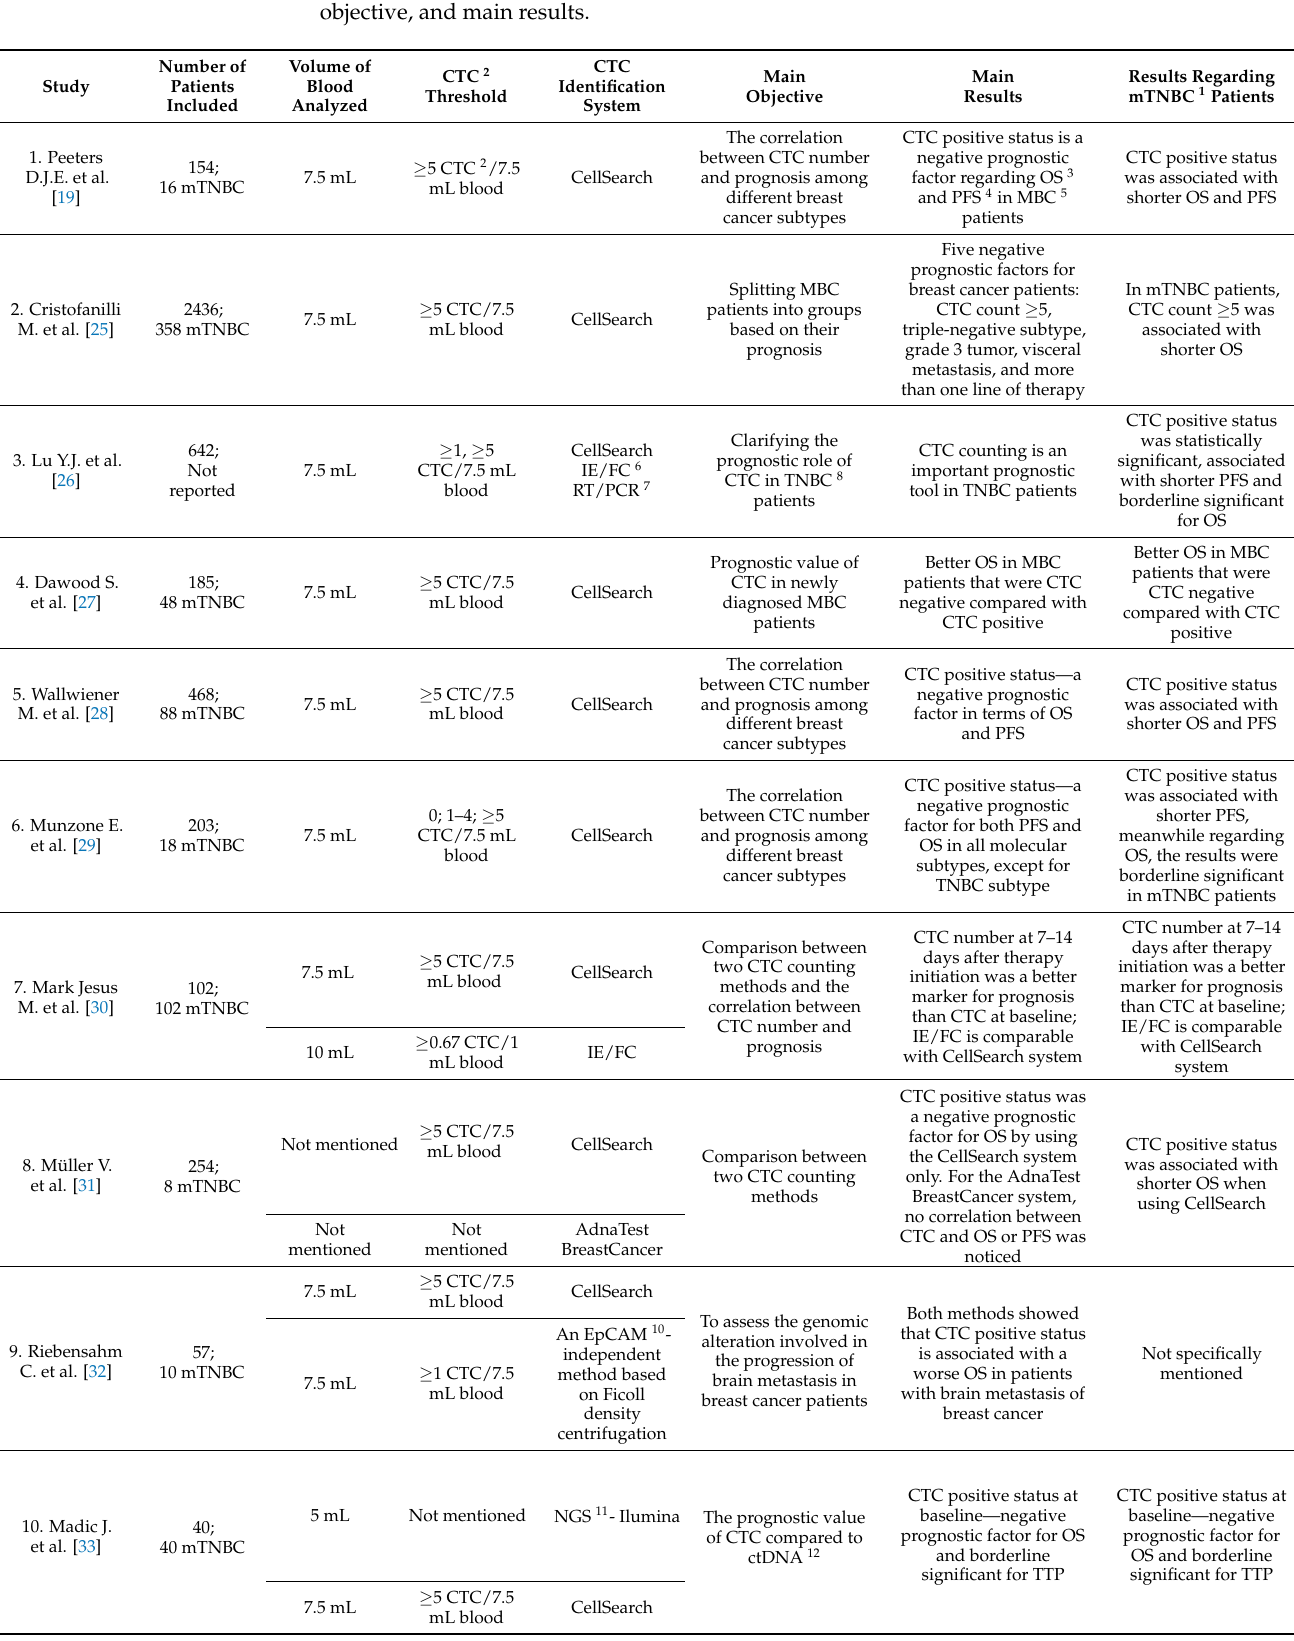
Table 2. The impact of circulating tumor cells upon the prognosis of the disease in mTNBC 1 : number of patients, volume of blood, CTC 2 threshold, technology used for their characterization, main objective, and main